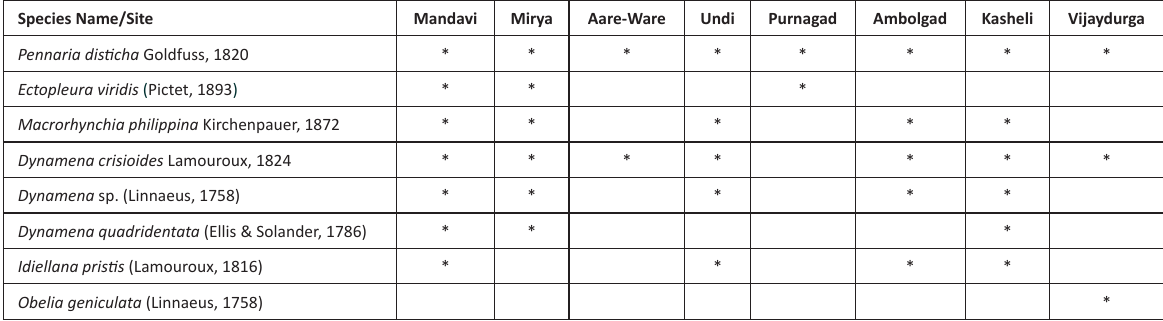
Table 1. Distribution of hydroids along various coasts of Ratnagiri